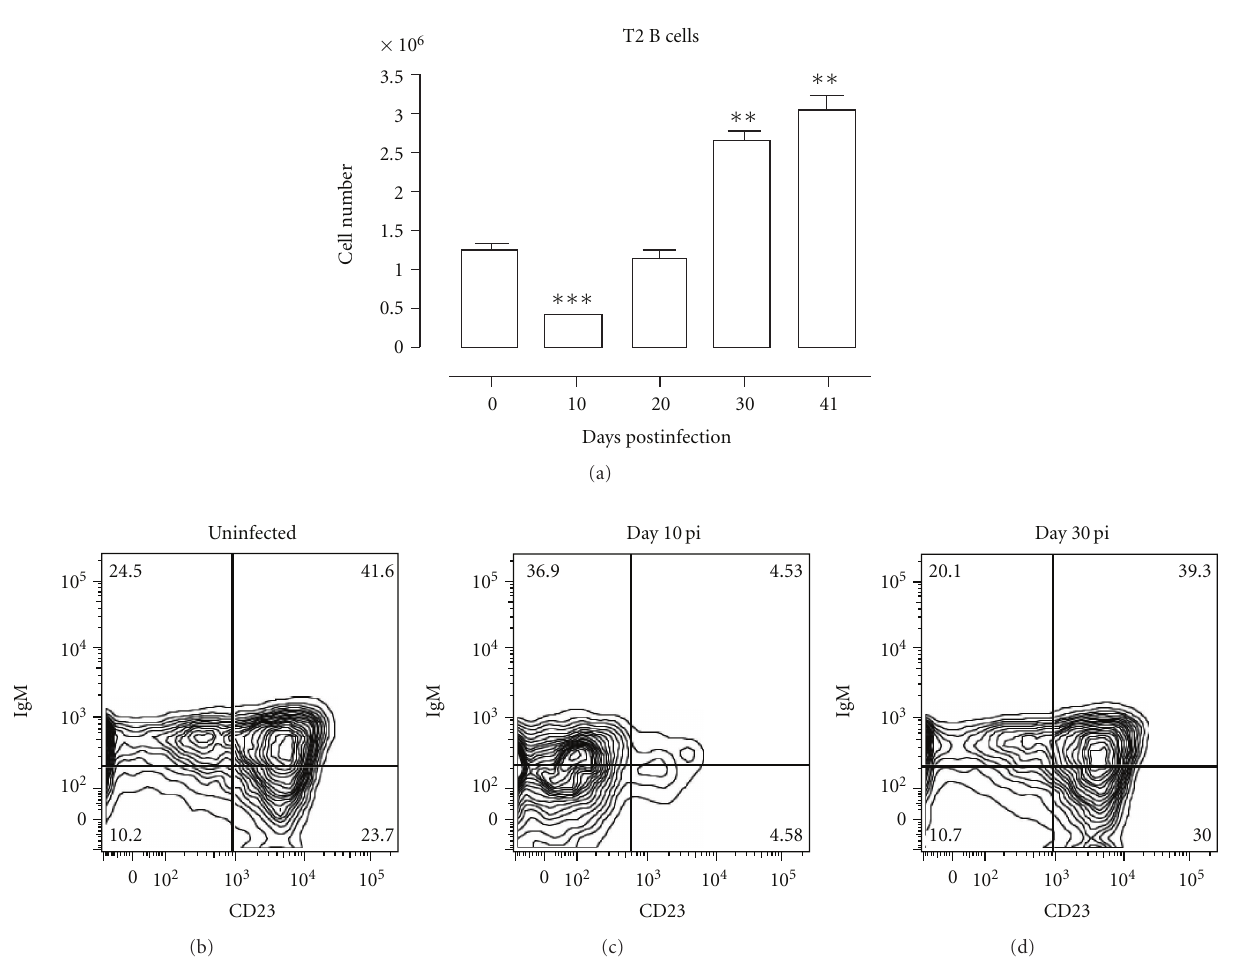
Figure 5: Depletion of transitional type 2 B cells in spleen during Pc AS infection. (a) Spleens cells from noninfected mice and mice infected with Pc AS for 10–41 days were stained for surface markers commonly used to define transitional T2 B cells and analyzed using FACS. Data are represented as mean of three mice per group ± SEM, two independent repeat experiments were performed and statistics are compared to uninfected controls ( ∗∗ ) P < . 01, ( ∗∗∗ ) P < . 001. (b), (c), and (d) Transitional T2 B cells were detected as (AA4.1 + B220 + ) IgM + CD23 + in uninfected mice and mice on day 10 and 30